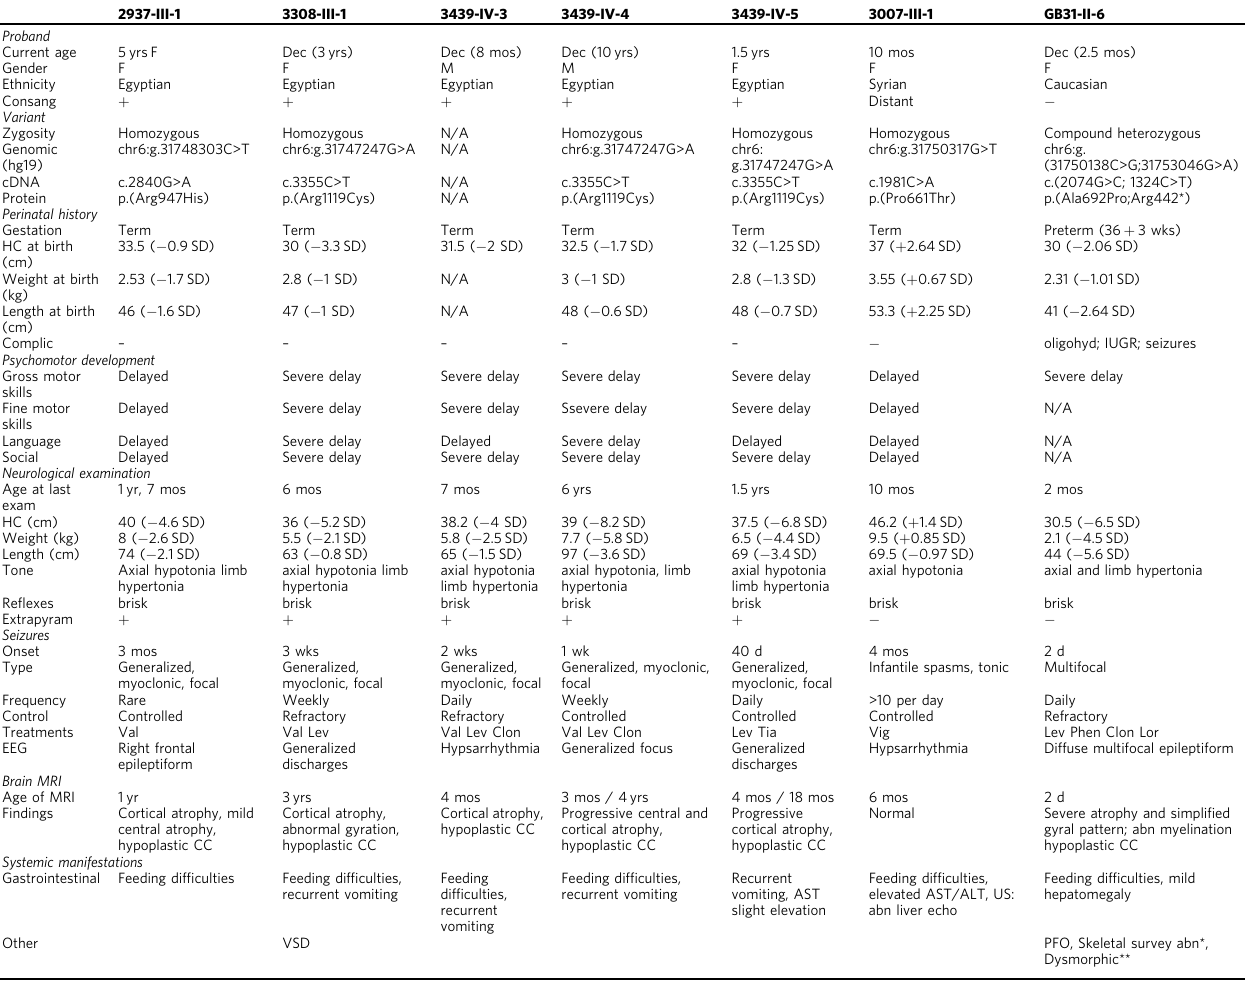
Table 1 Case phenotype and genotype